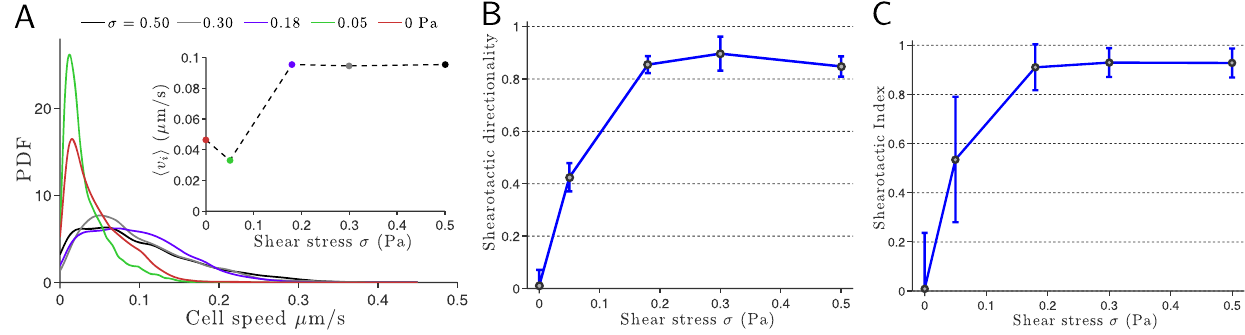
Figure 2. Influence of shear stress on shearotactic cell migration. (A) Influence on cell speed: probability density function (PDF) of the cell speed for five different magnitudes of the shearotactic signal with the associated average speed vs. shear stress in insert. For shear stress levels lower than 0.05 Pa, the average cell speed is of the order of the cell speed in the absence of any signal (insert). For values of s in the range 0.18 to 0.5 Pa, the average cell speed is found to be almost constant. This conclusion, established on the sole basis of first-order statistics of cell speed, is readily generalized by noticing the similarities in the PDFs of cell speed for 0.05 Pa on the one hand, and for 0.18 Pa on the other hand. (B) Evolution of the shearotactic directionality with the shear stress. (C) Evolution of the S i with the shear stress. S d is a measure of the instantaneous ability of the cell to migrate in the signal’s direction, while S i is an integrated measure of S d throughout the entire cell path. This subtle relationship between S d and S i is reflected in the above variations with the shear stress where a plateau about 0.9 is reached for s § 0.18 Pa. For all values of s , only cells adhering to the substrate throughout the entire duration of the experiment were considered and analyzed. All experiments were conducted with a soluble concentration of calcium, [Ca 2 + ] ext , set and fixed at 3 mM and cells are crawling over a plastic hydrophobic